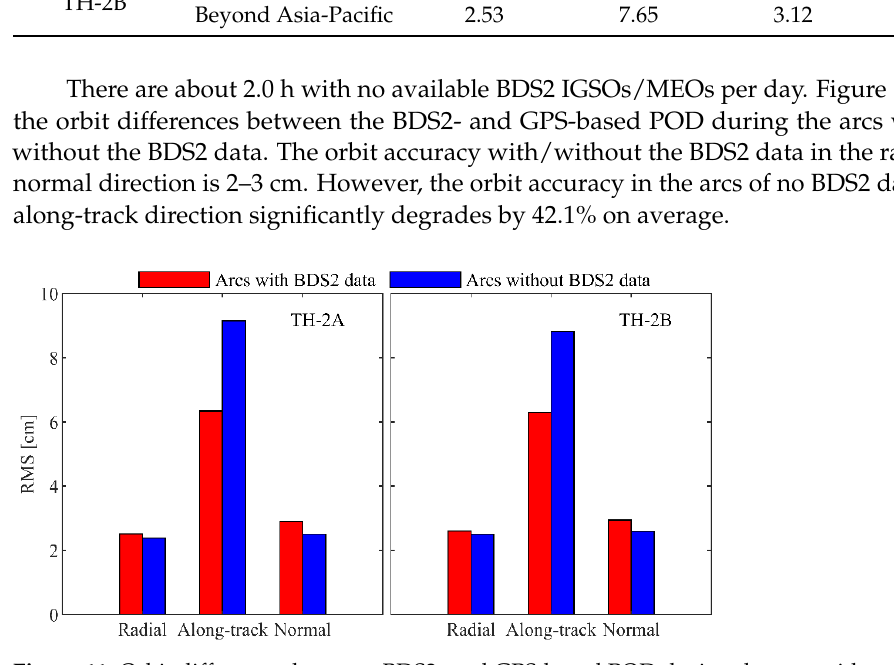
Figure 12. Orbit differences between BDS2 ‐ and GPS ‐ based POD in radial, along ‐ track, normal, and 3D directions for TH ‐ 2A ( top panel ) and TH ‐ 2B ( bottom panel ). 4.3. GPS and BDS2 Fused Results The combination of multi ‐ GNSS provides a better observation geometry and achieves a more robust positioning ability than a single navigation system. Therefore, it is necessary to analyze the results of the GC combined processing for the TH ‐ 2. In addition,